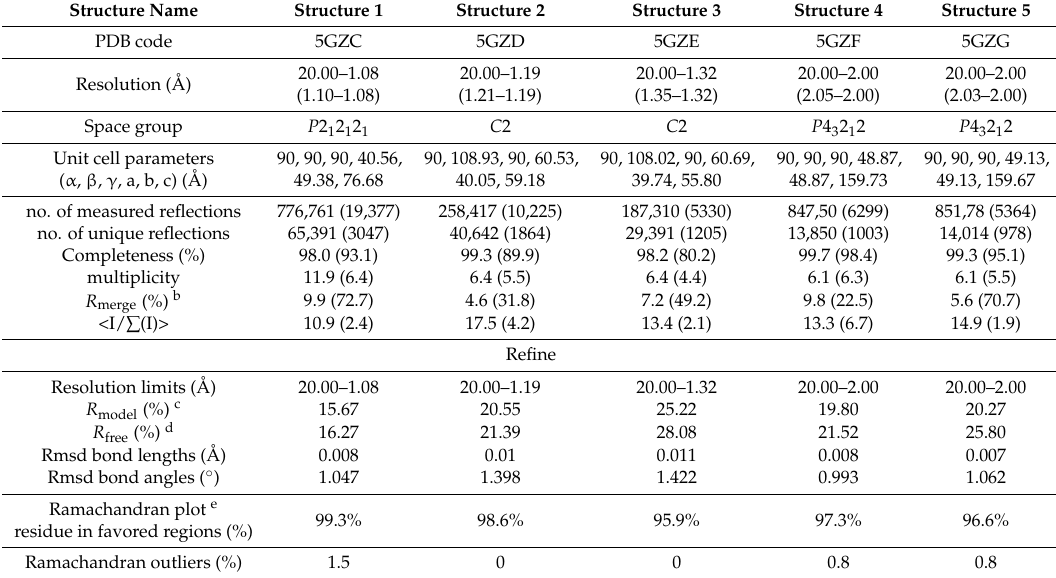
Table 1. Crystallographic data collection and refinement statistics a .